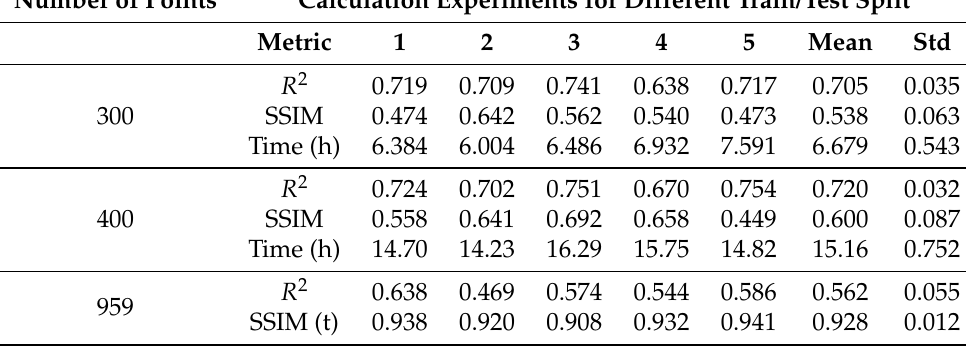
Table A1. Cont. Number of Points Calculation Experiments for Different Train/Test